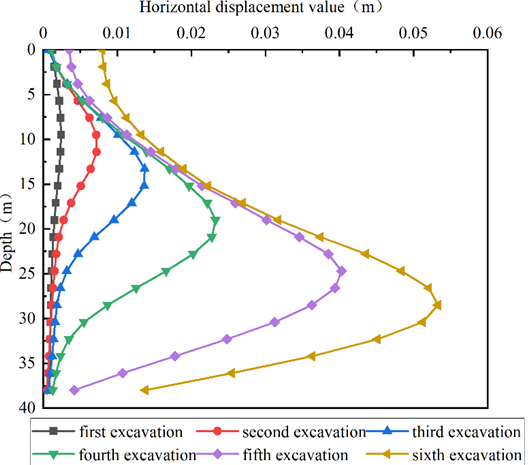
Figure 22. Horizontal displacement curve of foundation pit excavation enclosure structure without seepage point.